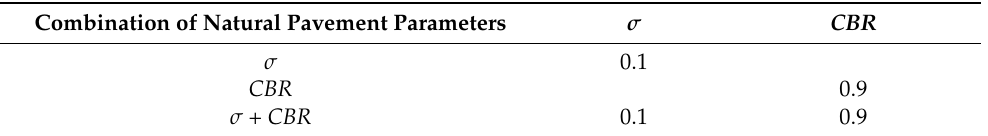
Table 4. Weights for various combinations of operational parameters of natural pavement of airfield functional element for calculating the APCI NN